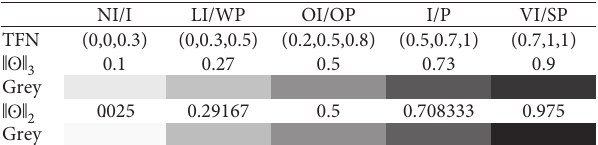
Table 1: Association between linguistic terms, fuzzy numbers, and their norms.